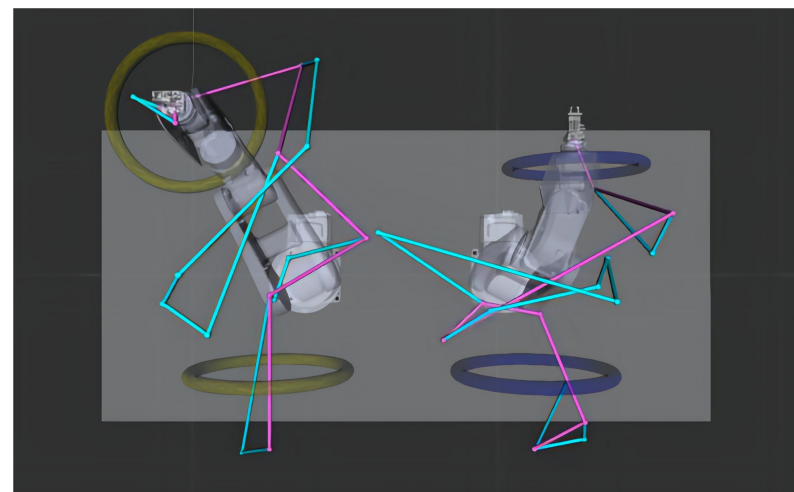
Figure 9. Comparison of original path and simplified path in RViz.